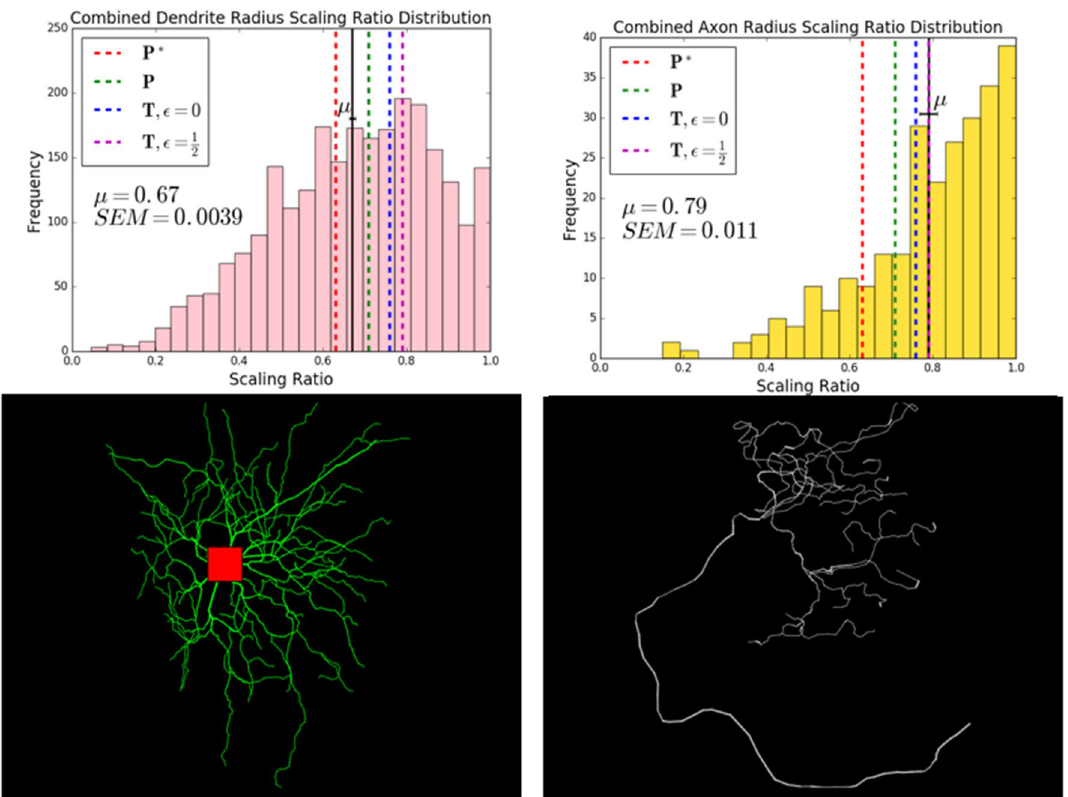
Figure 2. Comparison of dendrite and axon radius scaling ratio distributions, combined. Histograms showing the distributions of radius scaling ratios for axons and dendrites combined from a range of species, brain regions, and cell types available on NeuroMorpho.Org. The mean dendrite scaling ratio is 0.67 ± 0.004 and the mean axon scaling ratio is 0.79 ± 0.01 . In the figure, µ represents the mean and SEM represents the standard error of the mean (SEM). The standard deviations of the distributions are 0.20 for dendrites and 0.17 for axons. The black solid lines denote the mean in the distributions, shown with error bars, and the red, green, blue, and magenta dashed lines represent the theoretical predictions for various objective functions. The closest theoretical predictions for the dendrite scaling ratio mean are the optimal scaling ratios for function P , minimizing power with fixed volume, n − 1 / 2 ≈ 0.71 , and for function P* , minimizing power with fixed time delay, n − 2 / 3 ≈ 0.63 . The closest theoretical predictions for the axon scaling ratio mean are the optimal scaling ratios for function n − 1 / 3 ≈ 0.79 , and the unmyelinated case with T , minimizing time delay, the myelinated case with ǫ = 1 2 , ǫ = 0 , n − 2 / 5 ≈ 0.76 . We restricted radius scaling ratio data to values that are less than 1.0. The representative reconstruction images show the characteristic differences in morphology between dendritic and axonal trees. The dendritic tree, shown on the left, is taken from an elephant cerebellar Golgi cell 28 . The axonal tree, with a representative long parent branch, is taken from a mouse touch receptor 53